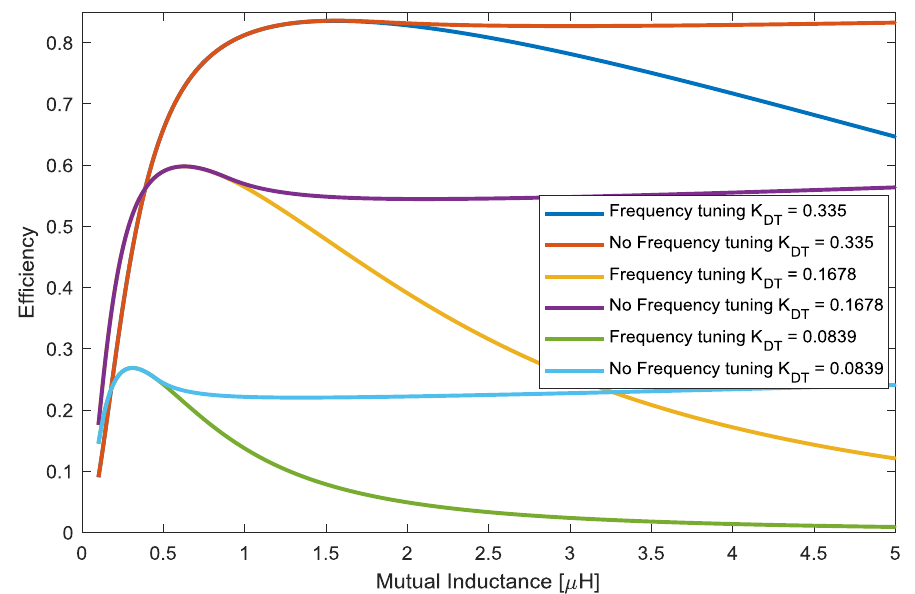
Figure 7. Effects on the efficiency due to the frequency tuning in a SCMR system.